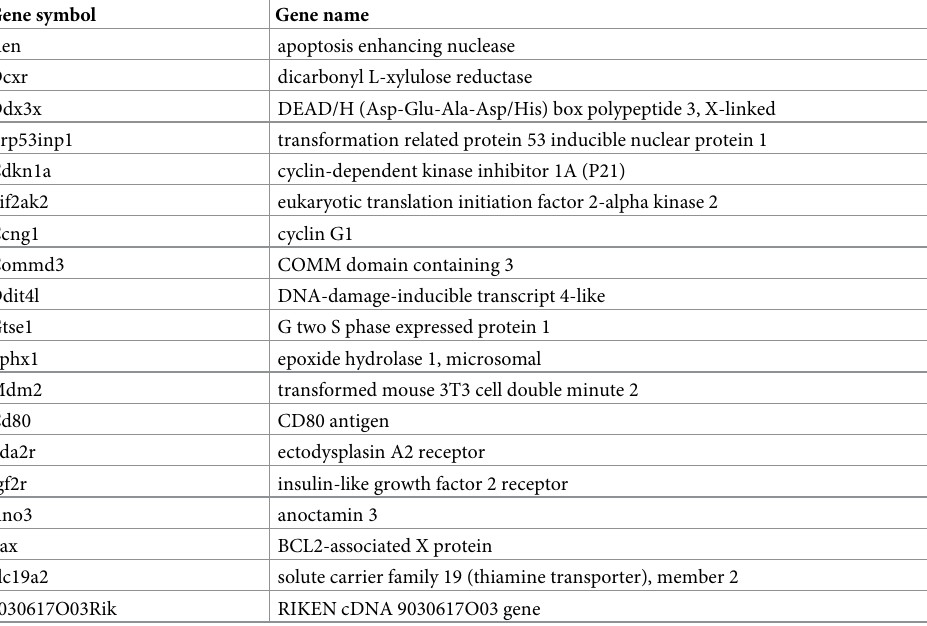
Table 2. Dose-responsive genes to both gamma and proton